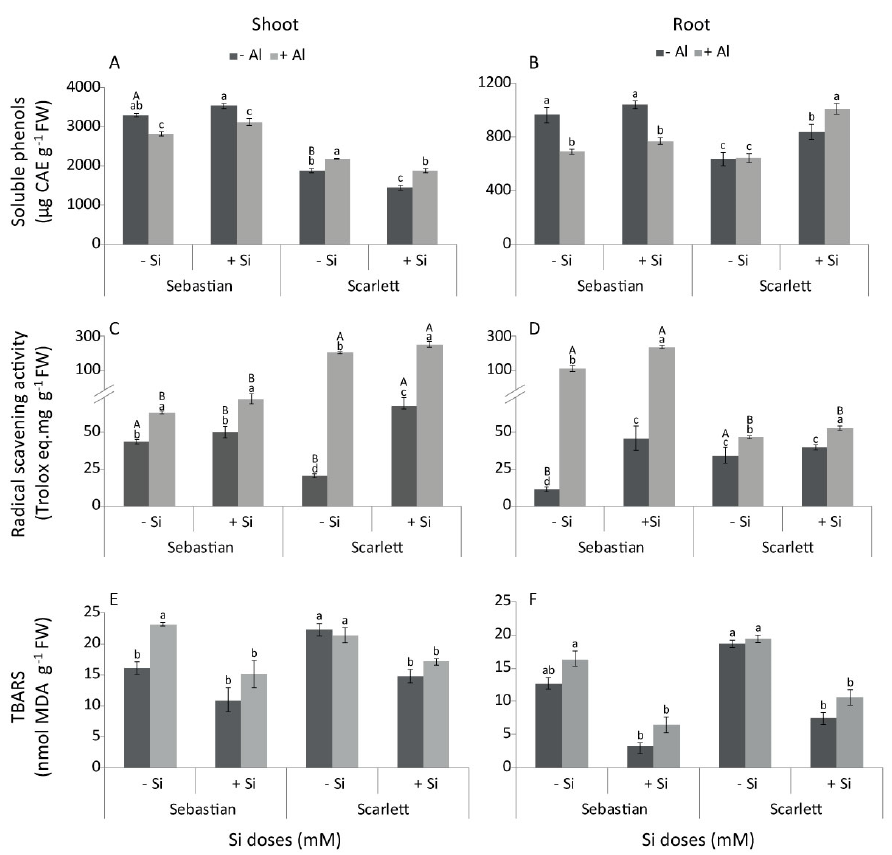
Figure 1. Total phenols ( A , B ), free radical scavenging activity ( C , D ) and lipid peroxidation ( E , F )